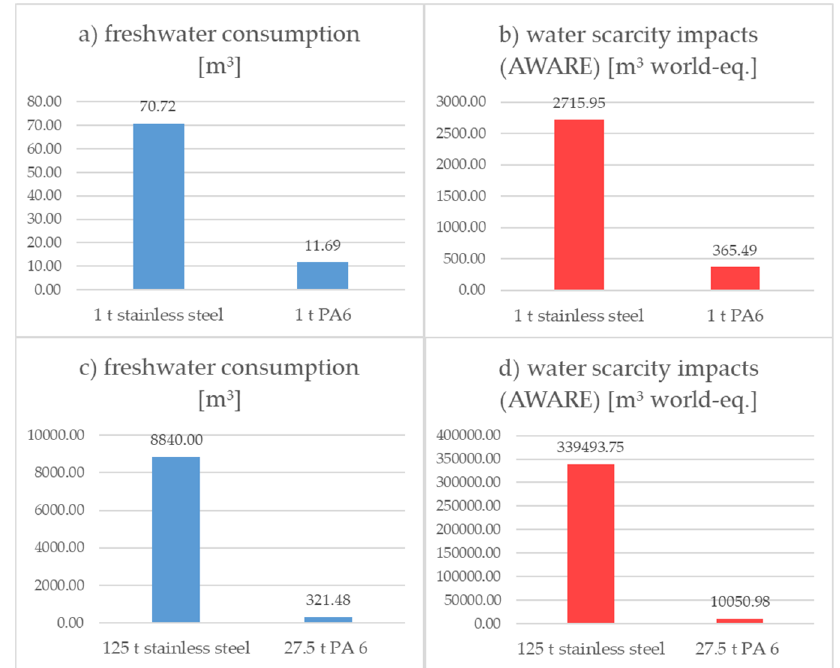
Figure 7. Comparison between the freshwater consumption and the potential water scarcity impacts of stainless steel and PA6. A comparison by mass is provided in ( a ) for freshwater consumption and ( b ) for water scarcity impacts; ( c , d ) compare the results for the respective amounts of stainless steel and PA6 needed to reinforce the same number of hoses with respect to freshwater consumption ( c ) and water scarcity impacts ( d ). Own figure base on calculations realized via the WELLE tool [36]. Own figure.